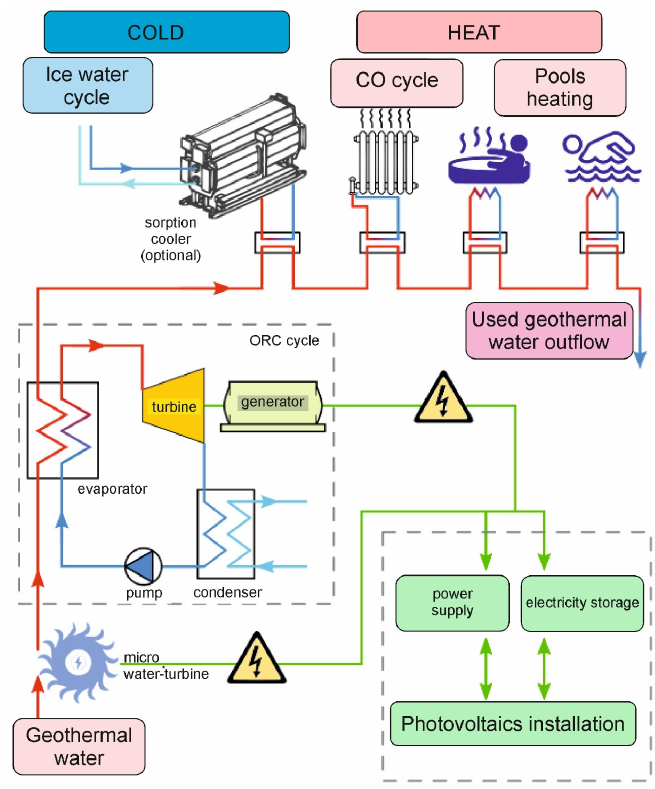
Figure 3. The new hydro-geo-solar system.